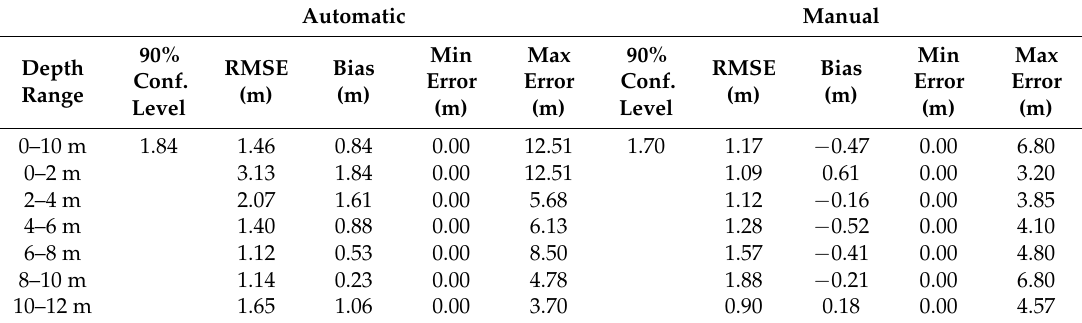
Figure 5. ( A ) Evaluation of the RMSE calculated for the automatic and manually extracted DSMs (up to 12 m) using overlapping survey points. ( B ) RMSE for the manually extracted DSM up to 20 m using all survey points. Table 4. RMSEs and 90% confidence levels for automatic and manual approaches.